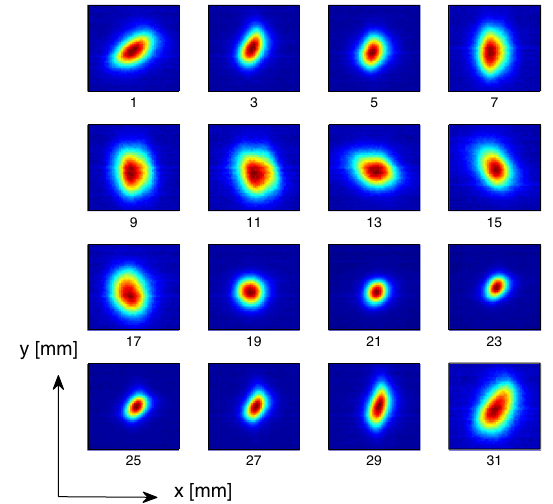
FIG. 8. Measurement example. Beam images for every other scan step. See also Fig.